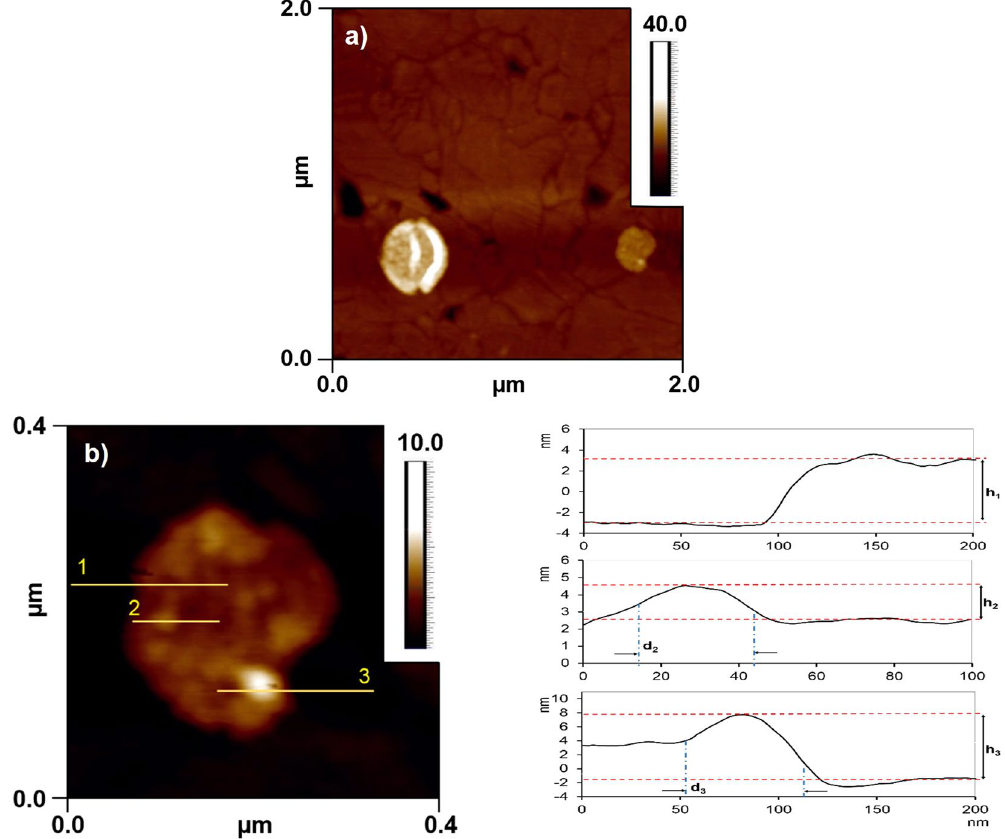
Figure 9. AFM images of the PSI-proteoliposomes supported on gold surfaces. ( a ) Bare gold substrate and PSI- proteoliposomes; ( b ) zoomed in images of PSI-proteoliposomes and representative cross-sectional surface profiles (1) for lipid bilayer assembled on gold surface (h 1 ~ 5 nm); (2) for membrane-bound PSIs (h 2 ~ 2 nm, d 2 ~ 30 nm) and (3) for membrane-adsorbed PSI (h 3 = 8.5 nm, d 3 = 50 nm) are shown for the respective AFM